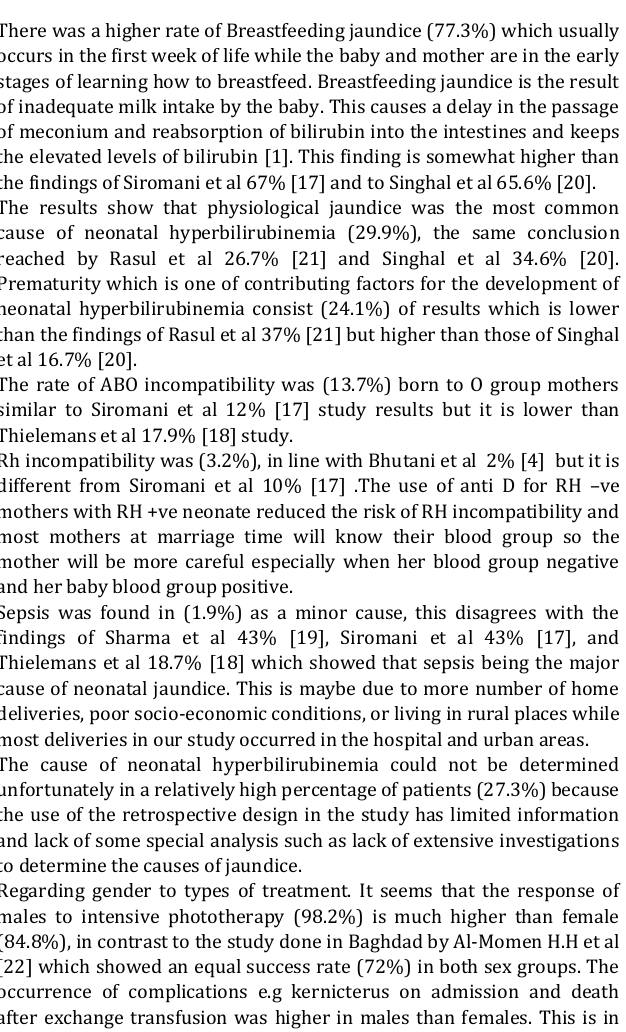
protocol #22: guidelines for management of jaundice in the breastfeeding infant equal to or greater than 35 weeks'